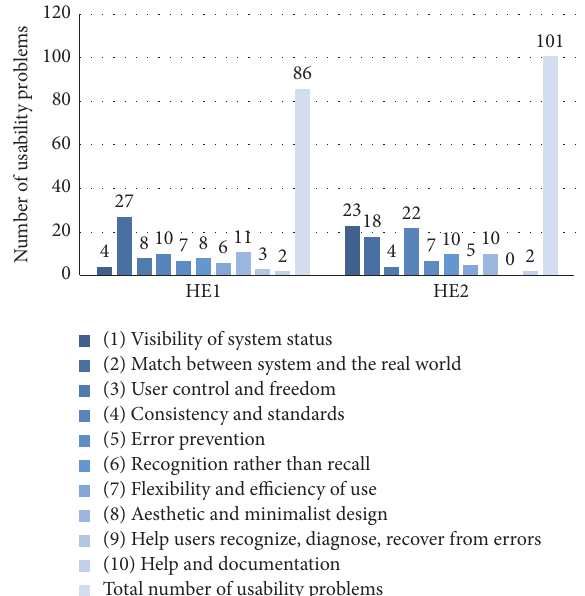
Figure 2: Distribution of usability problems by heuristic for both heuristic evaluations (HE1 and